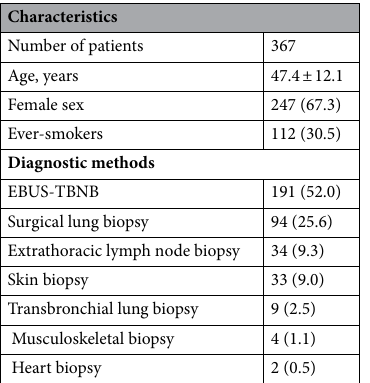
Table 1. Baseline characteristics of the study population. EBUS-TBNB, endobronchial ultrasound-guided transbronchial needle